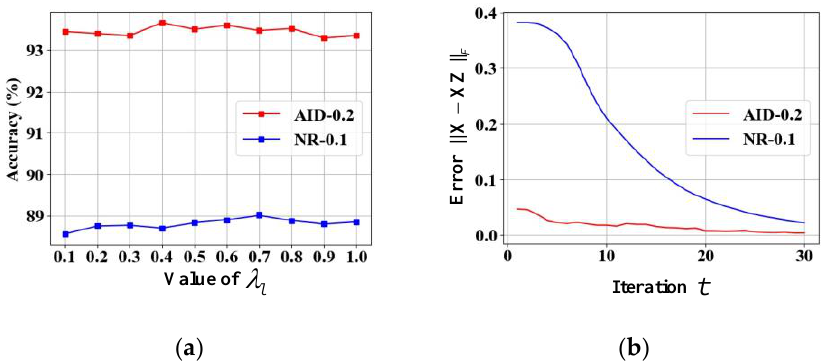
Figure 16. Analysis of ( a ) the trade-off parameter λ l and ( b ) the convergence of the subspace learning.